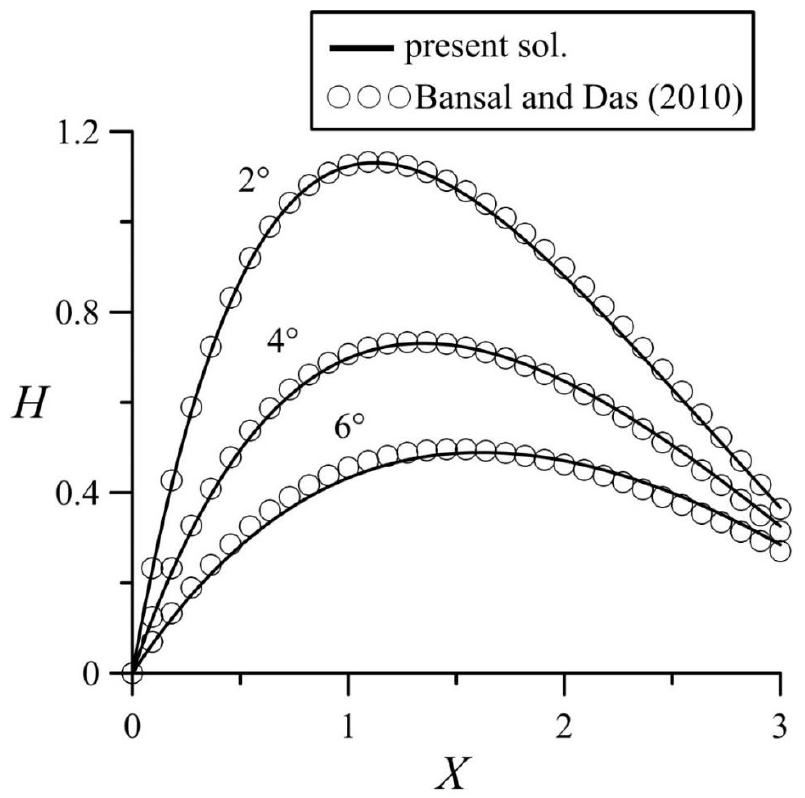
Figure 2. Transient variation of groundwater table under constant recharge rate for 𝜃 = 2° , 𝜃 = 4° , and 𝜃 = 6° .